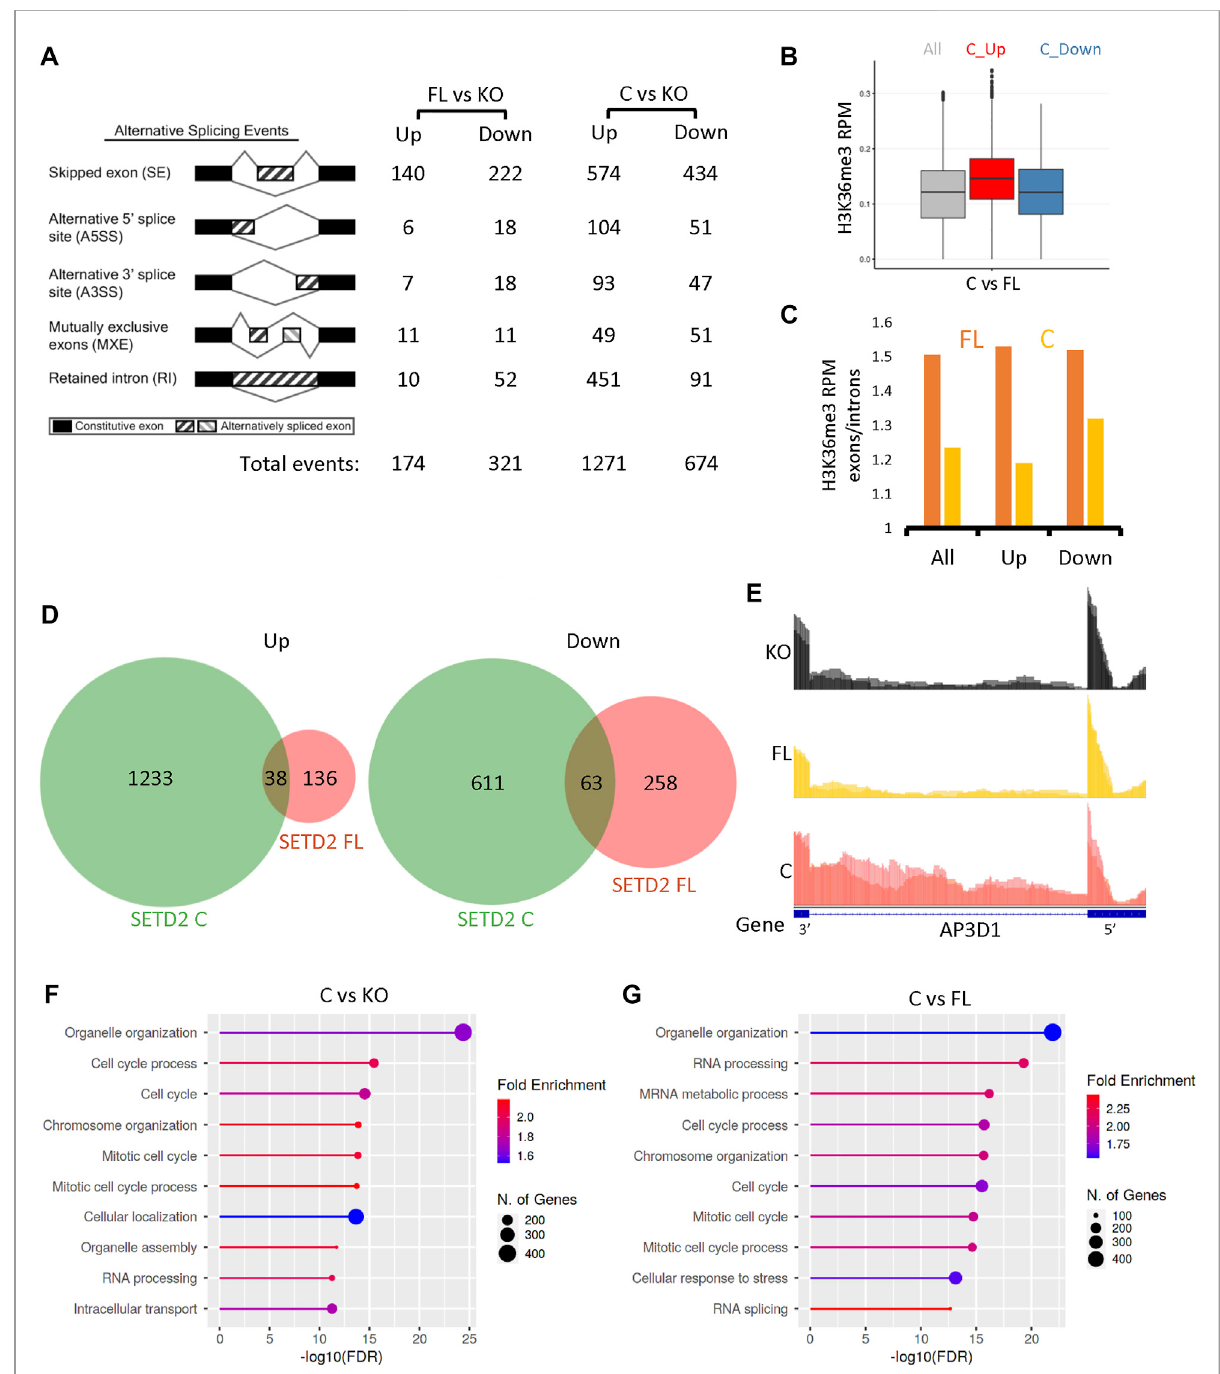
FIGURE 3 SETD2 accumulation leads to alternative splicing defects. (A) RMATS analysis depicting the differential AS events in SETD2 FL and SETD2 C expressing KO cells. The cartoon was taken from http://rnaseq-mats.sourceforge.net/. (B) A box plot showing the H3K36me3 level of genes that show differential alternative splicing upon SETD2 C expression as compared to SETD2 FL. In the boxplots, the black line inside the box shows the median.Theboxbottomandtopbordercorrespondto25thand75thpercentiles(Q1andQ3respectively).Thewhiskersrepresentrangesfrom